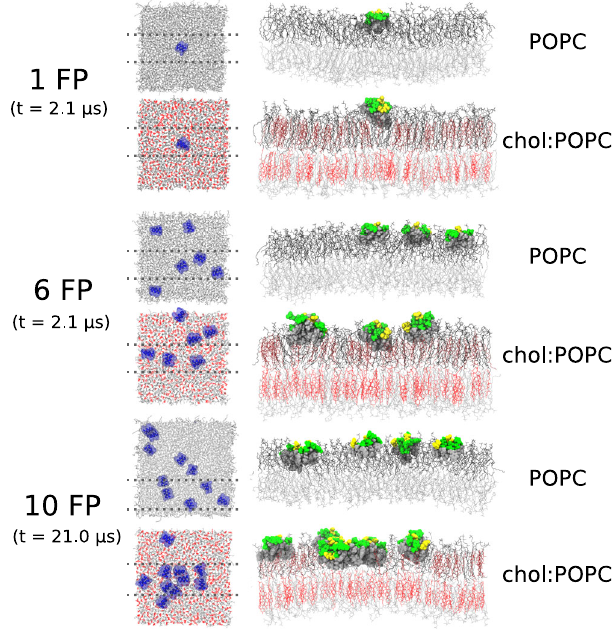
Fig. 3 | Snapshots of microsecond time-scale MD simulations. Final simulation snapshots. POPC and cholesterol are shown in grey and red line representations; FPs aredepicted asblue-ribbondiagramswith a translucent space- fi lling overlayin the top-down views. Sideviewofthe fi nalsimulationsnapshots are taken as a 40Å section denoted by the dotted lines in the top-down views; lipids in the cis lea fl et are depicted in darker shades to distinguish them. FPs are depicted in a Van der Waals sphere representation, with hydrophobic residues in grey, while polar resi- dues are green and acidic residues are